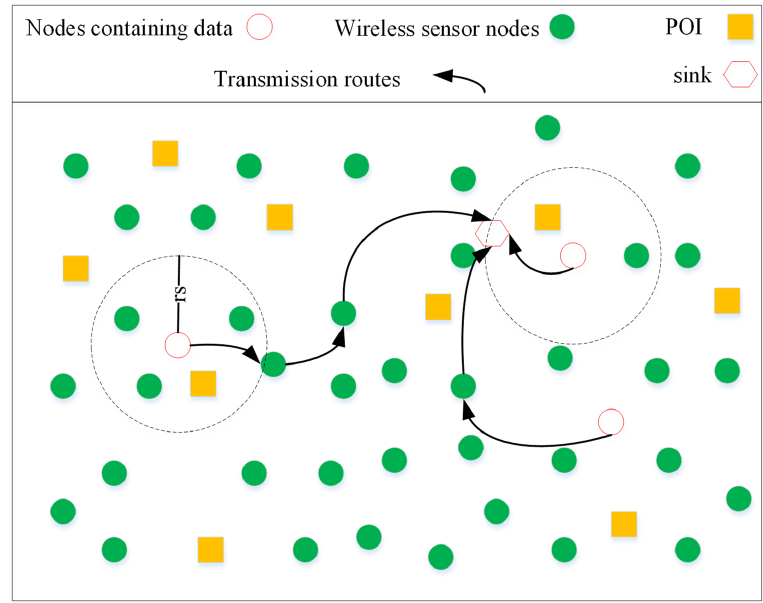
Figure 1. Events sending at star points with neighboring nodes to the sink.